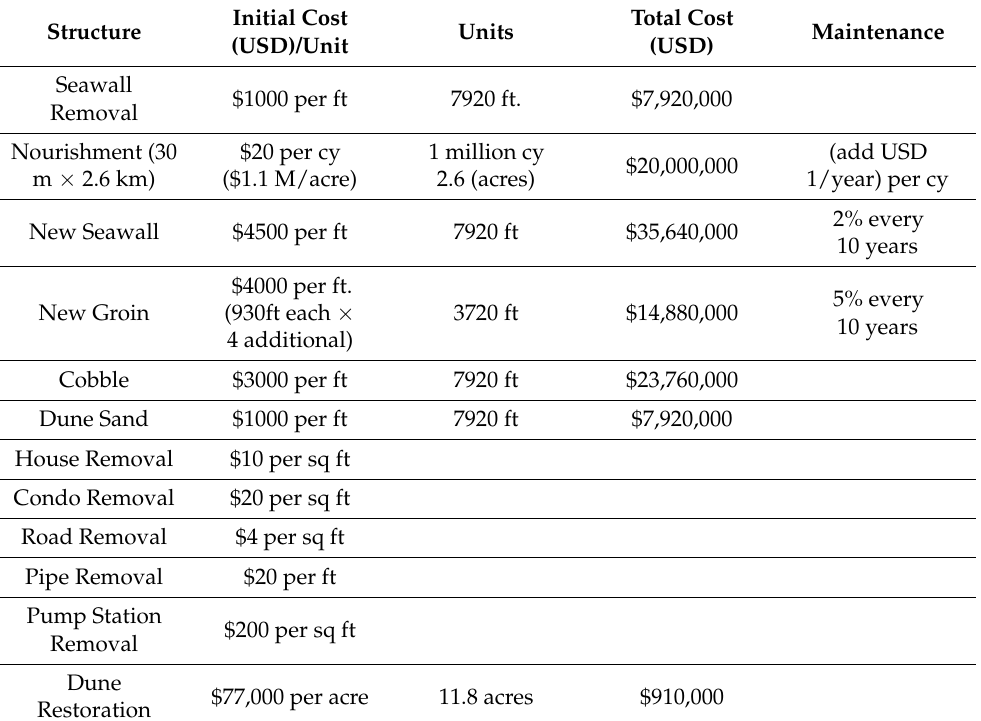
Table 4. Engineering construction and maintenance cost estimate break down by unit costs. Source Joe Ellis, P.E., Marathon